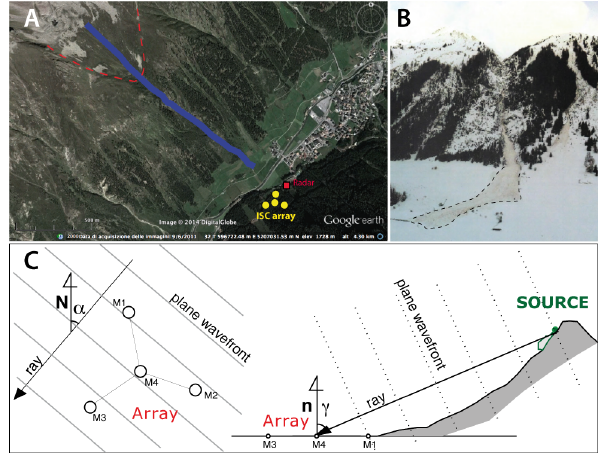
Figure 1. (a) Google Earth view of the Paznaun valley near Ischgl (Austria), showing the position of the Grosstal avalanche path (blue line) and starting area (dashed red line) and the position of the mon- itoring radar (red square) and the infrasound array (yellow circles) deployed during the 2012/2013 winter season. (a) Picture of the 23 December 2012 Grosstal avalanche taken in the morning ∼ 7–8h after the event. (c) Sketch of infrasound array geometry and corre- sponding wave parameters: notation of back azimuth ( α) and take- off angle ( γ) is the same as in the text.